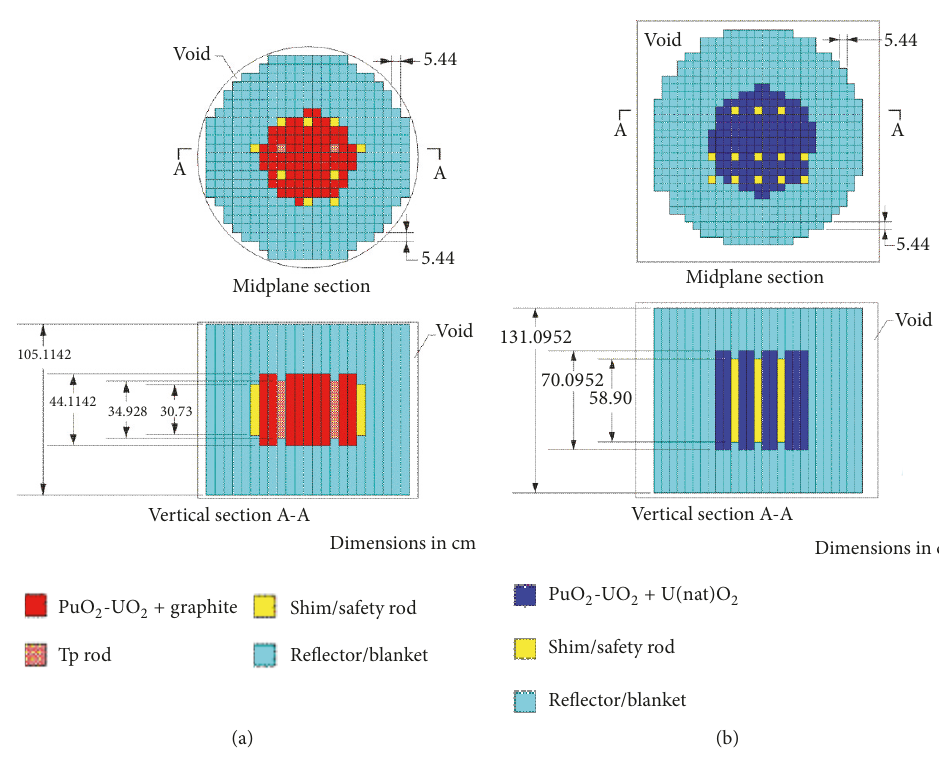
Figure 6: Cross cuts of detailed and simplified 3D benchmark models of the SNEAK 7A (a) and SNEAK-7B (b) fast reactor assemblies.